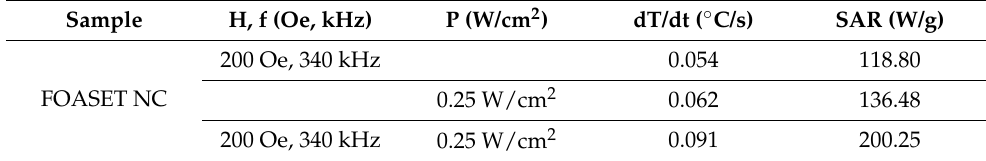
Table 1. Experimental values of SAR and (dT/dt) of FOASET NC.